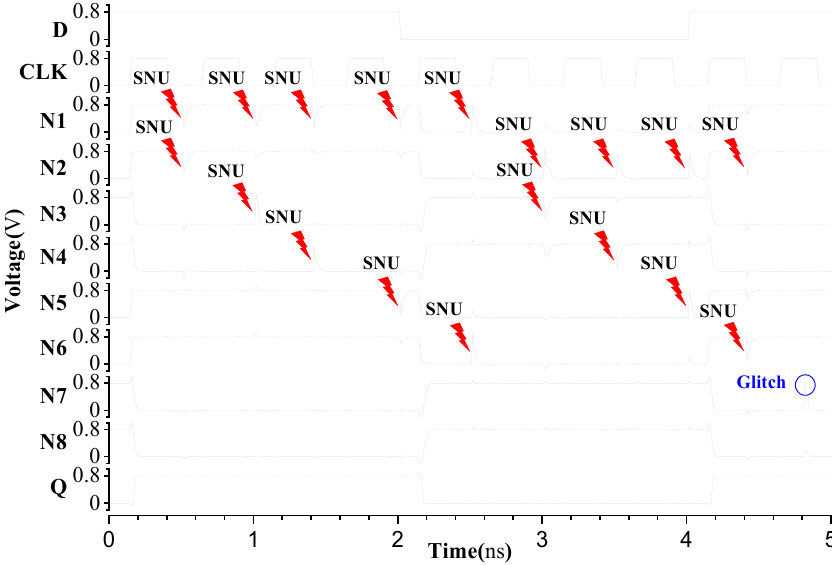
Figure 11. Simulation waveforms for DNURF considering DNU on representative node pairs.